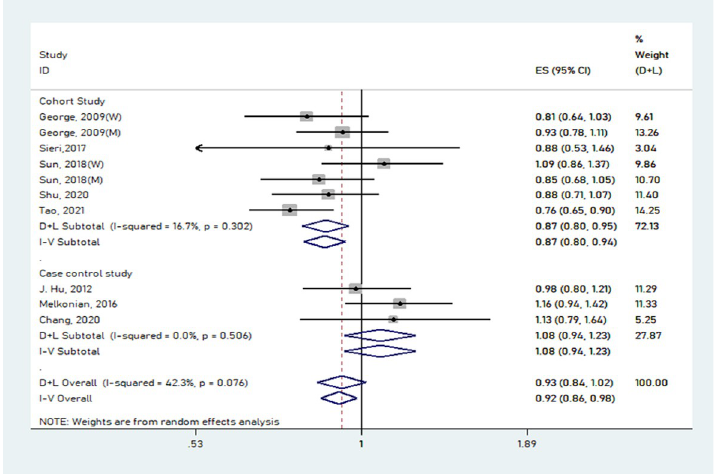
Fig 6. Forest plot showing risk estimates of the association between GI and lung cancer risk.